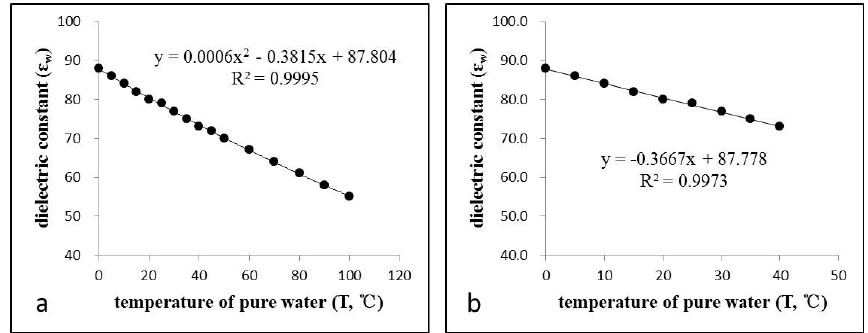
Figure 5. The pure water dielectric constant with temperature variation; (a) water temperature from 0 ℃ to 100 ℃ and the unary quadratic linear fitting result; (b) water temperature from 0 ℃ to 40 ℃ 0 ◦ C to 100 ◦ C and the unary quadratic linear fitting result; ( b ) water temperature from 0 ◦ C to 40 ◦ C and the straight linear fitting result. and the straight linear fitting result.